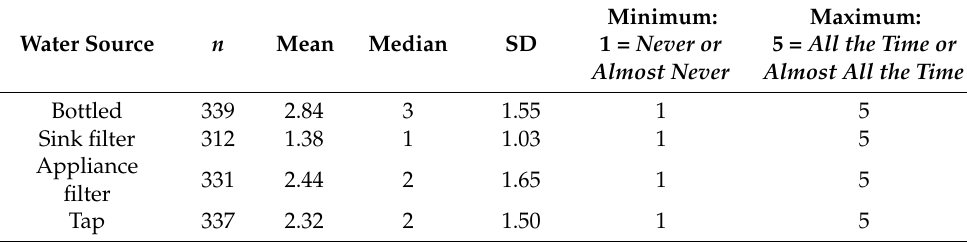
Table 1. Descriptive statistics for water source choice item. Statistics for each water source include number of observations ( n ), mean, median, standard deviation (SD), minimum scale value (minimum) and maximum scale value (maximum).